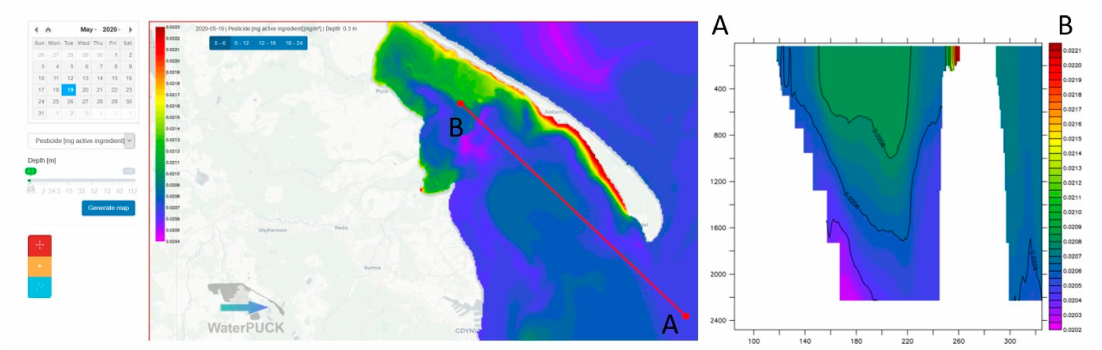
Figure 18. Screenshot of spatial distribution of pesticide concentration and sample cross section (AB - end points of the cross-section along the Hel